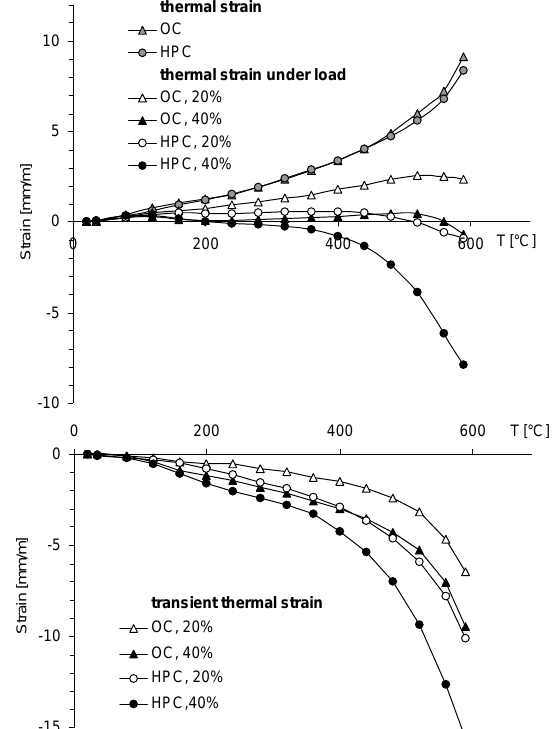
Figure 5. Thermal strains, thermal strains under load and transient thermal strains for HPC and OC (results from [41, 42], reproduced with authorization from